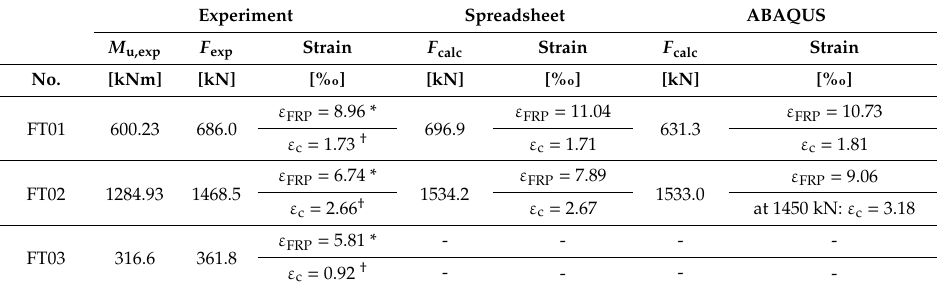
Table 5. Comparison of ultimate loads and strains in compression chord and main reinforcement. Experiment Spreadsheet